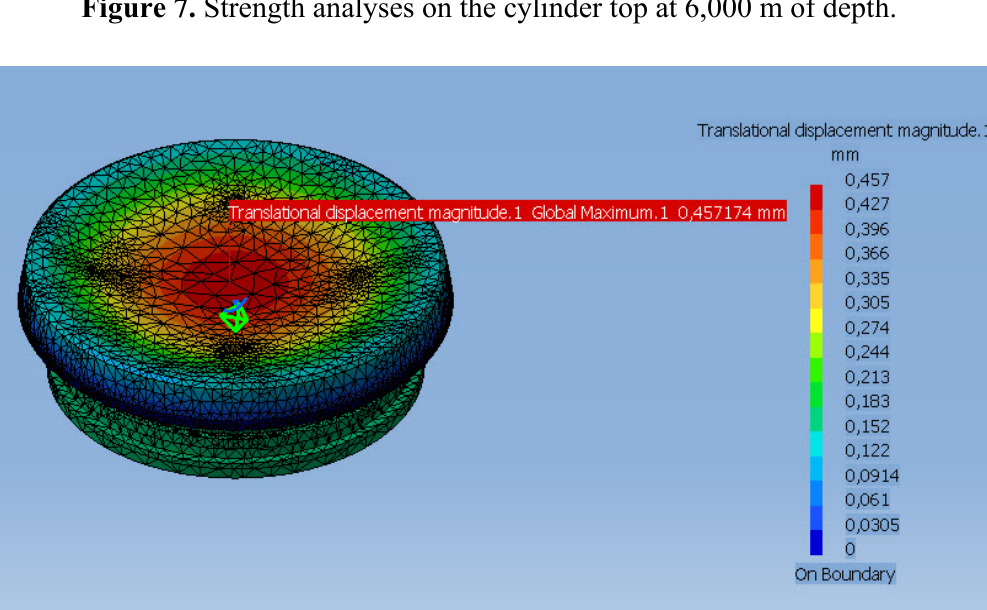
Figure 7. Strength analyses on the cylinder top at 6,000 m of